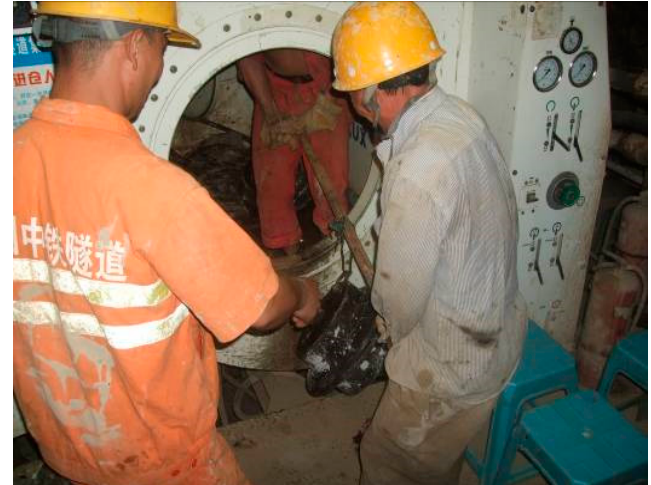
Figure 1. Soil sampling at the tunnel face.